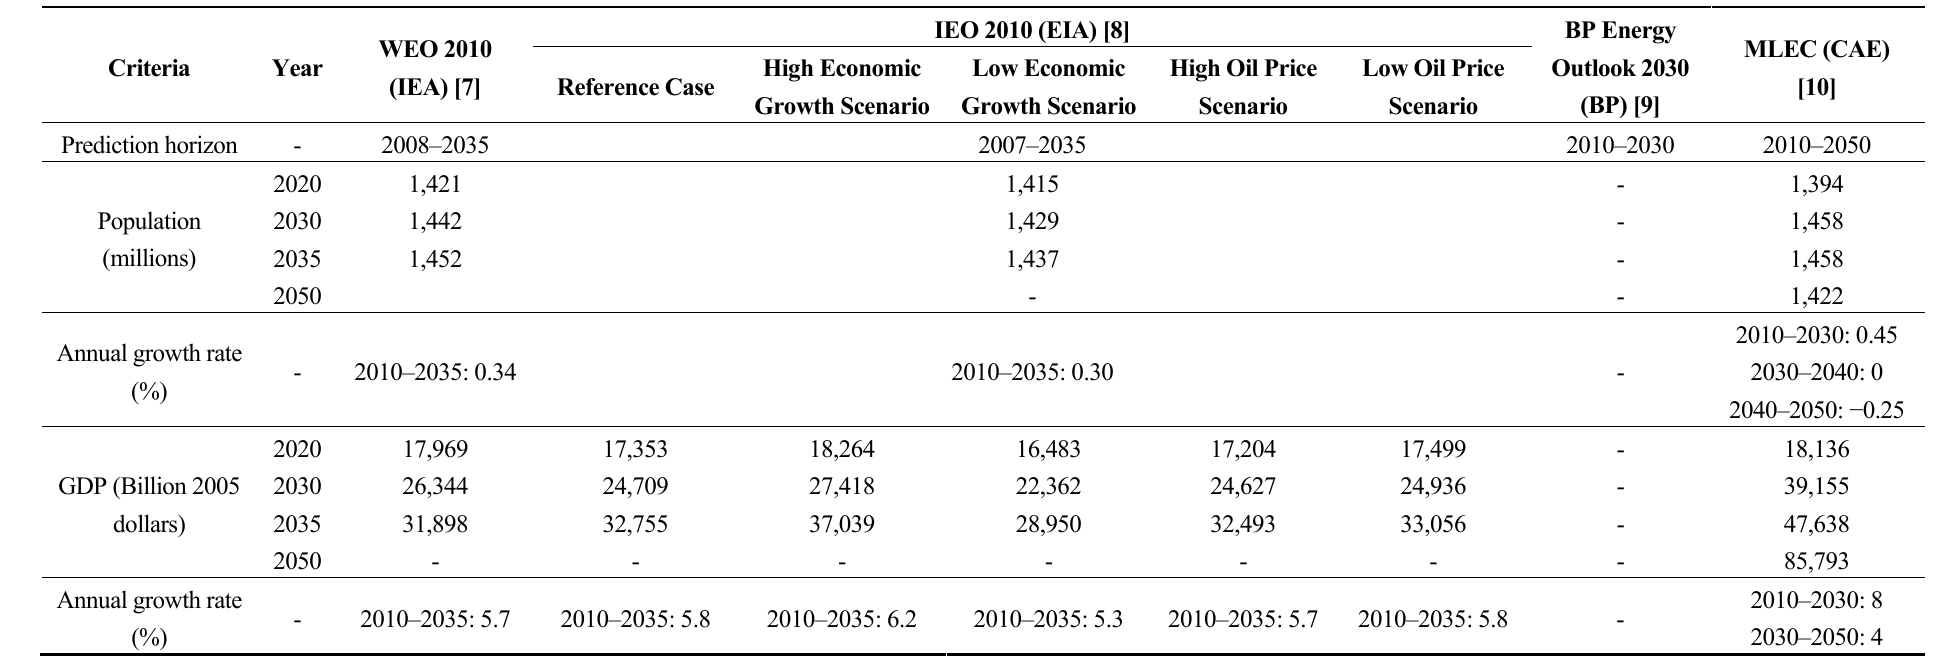
Table 3. Key scenario settings in scenarios of projection energy consumption of